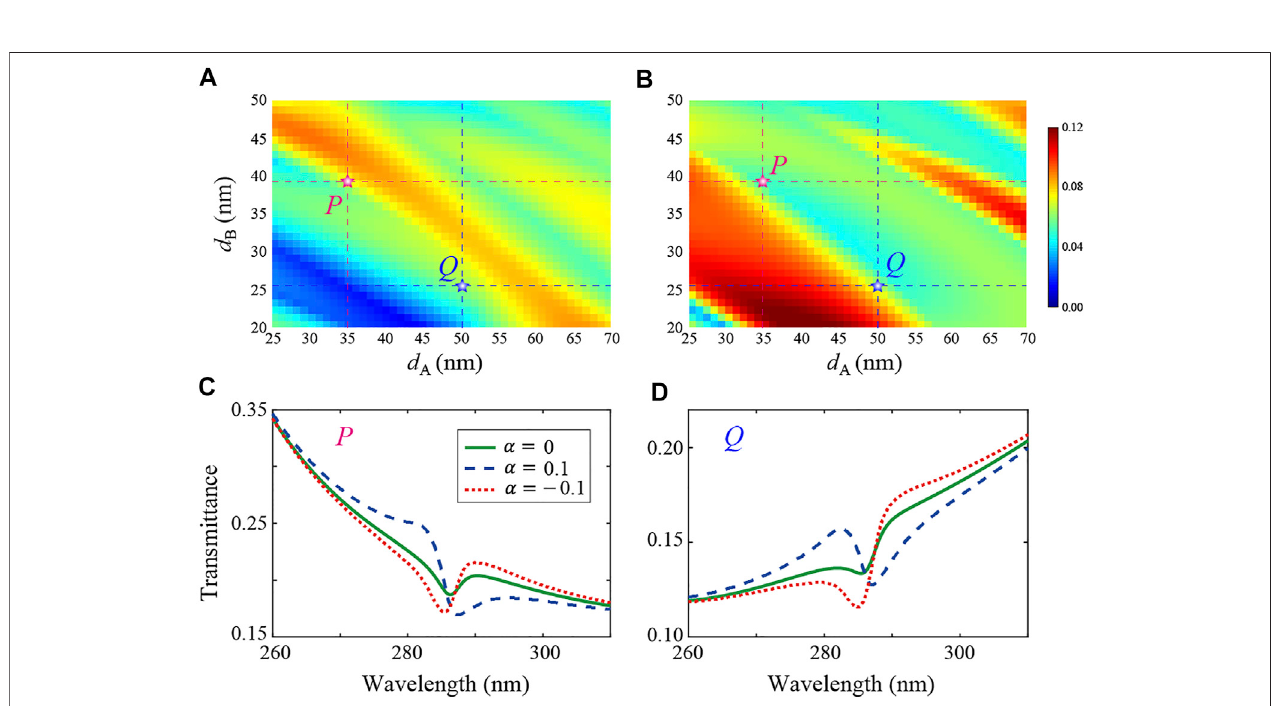
FIGURE 8 | (A) Maximum of Δ T 2 as a function of the thickness of layer A and layer B . (B) Similar to (A) , but for the maximum of − Δ T 2 . The places where Fano line changes sharply are distinguished by dashed lines. The case d A = 35 nm (50 nm) and d B = 39 nm (26 nm) is marked by P ( Q ). (C) The transmittance spectrum of the composite structure P for different MO coef fi cient: α = 0 (solid green line), α = 0.1 (dashed blue line) and α = − 0.1 (dotted red line), respectively. (D) Similar to (C) , but for the composite structure Q.